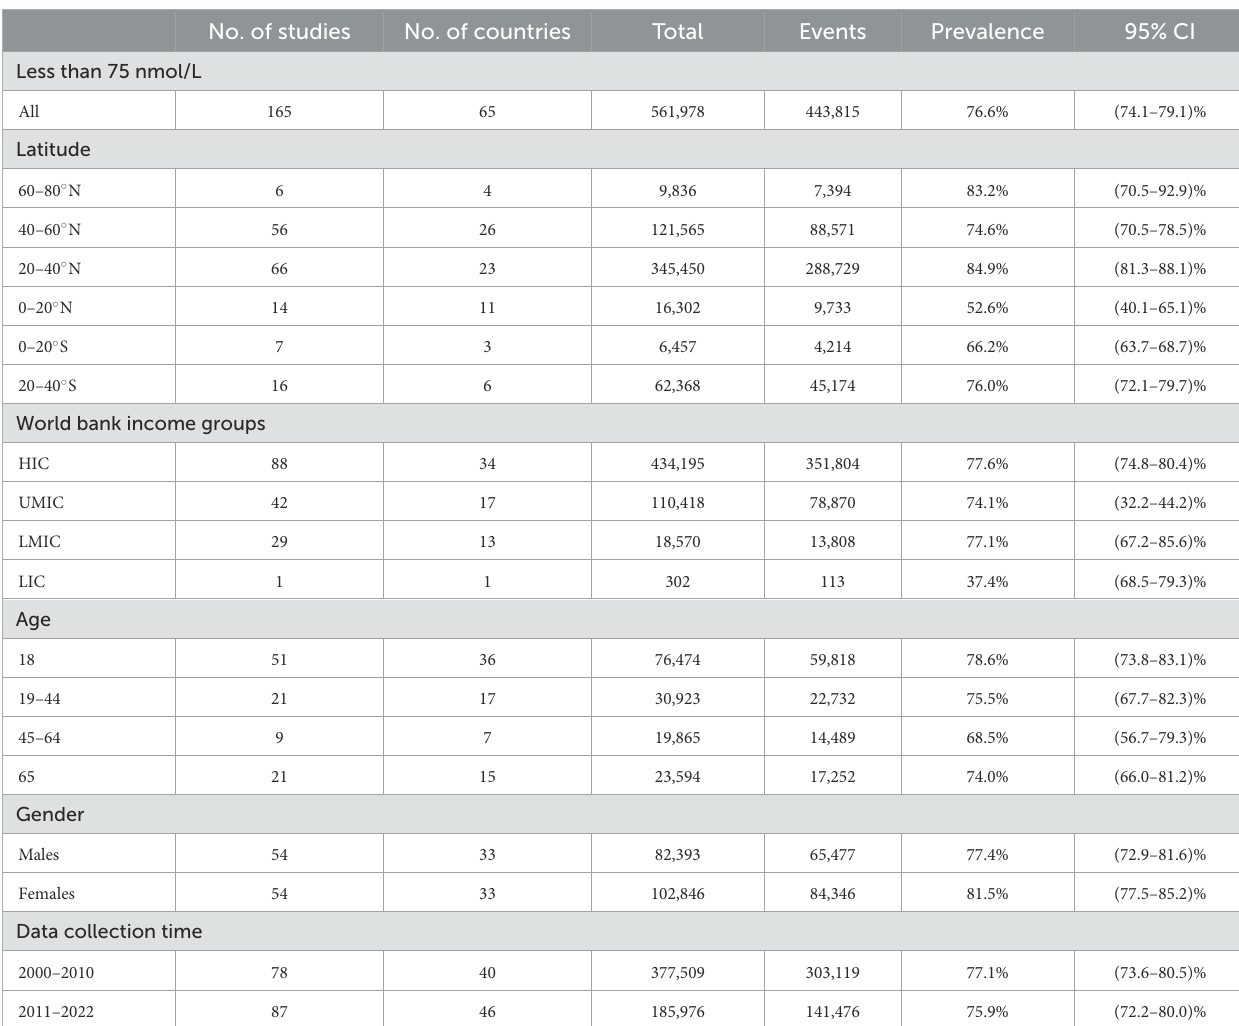
TABLE 3 The prevalence of serum 25-hydroxyvitamin D levels < 75 nmol/l. No. of studies No. of countries Total Events Prevalence 95%